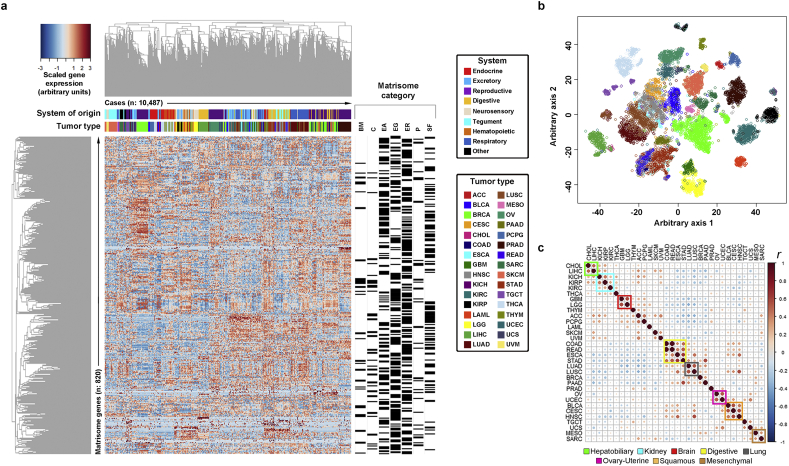
The cancer matrisome. (a) Heatmap of the expression of 820 matrisome genes in 10,487 cases from 32 tumor types. The matrisome category of each gene is given on the right as black bars, while tumor types and system of the body from which each tumor originates are color-coded and placed on top of the heatmap. The distance metrics for hierarchical clustering is 1-Pearson correlation (r). Abbreviations: ACC, adrenocortical cancer; BLCA, bladder urothelial carcinoma; BRCA, breast invasive carcinoma; CESC, cervical and endocervical cancer; CHOL, cholangiocarcinoma; COAD, colon adenocarcinoma; ESCA, esophageal carcinoma; GBM, glioblastoma multiforme; HNSC, head & neck squamous cell carcinoma; KICH, kidney chromophobe; KIRC, kidney clear cell carcinoma; KIRP, kidney papillary cell carcinoma; LAML, acute myeloid leukemia; LGG, brain lower grade glioma; LIHC, liver hepatocellular carcinoma; LUAD, lung adenocarcinoma; LUSC, lung squamous cell carcinoma; MESO, mesothelioma; OV, ovarian serous cystadenocarcinoma; PAAD, pancreatic adenocarcinoma; PCPG, pheochromocytoma & paraganglioma; PRAD, prostate adenocarcinoma; READ, rectum adenocarcinoma; SARC, sarcoma; SKCM, skin cutaneous melanoma; STAD, stomach adenocarcinoma; TGCT, testicular germ cell tumor; THCA, thyroid carcinoma; THYM, thymoma; UCEC, uterine corpus endometrioid carcinoma; UCS, uterine carcinosarcoma; UVM, uveal melanoma. BM, basement membranes; C, collagens; EA, ECM-affiliated; EG, ECM glycoproteins; ER, ECM regulators; P, proteoglycans; SF, secreted factors. (b) Multidimensional scaling of the data in (a) by T-distributed Stochastic Neighbor Embedding (t-SNE). (c) Inter-tumor correlation (Pearson correlation (r)) based on the 100 most-expressed matrisome genes in each tumor type. Clusters of highly correlated tumor types are reported as colored squares.